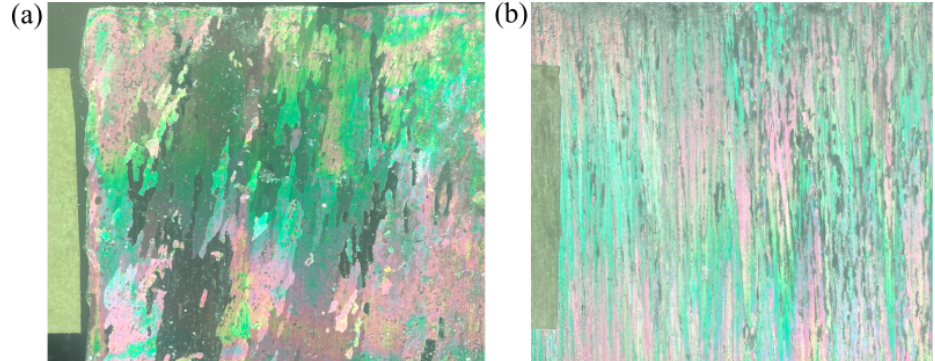
Figure B2. (a) Horizontal and (b) vertical thin sections of columnar sea